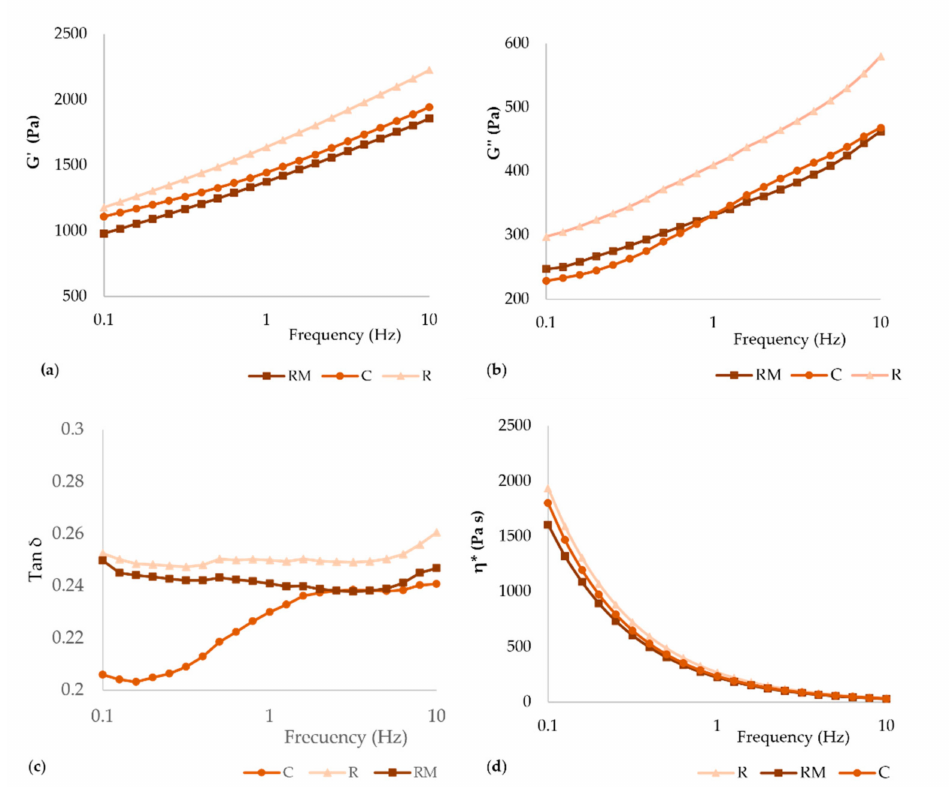
Figure 2. Rheological properties of gluten-free dough: ( a ) storage modulus G (cid:48) , ( b ) loss modulus G (cid:48)(cid:48) , ( c ) loss factor tan δ , and ( d ) complex viscosity versus frequency (Hz). (C, control; R, rosehip; RM, encapsulated